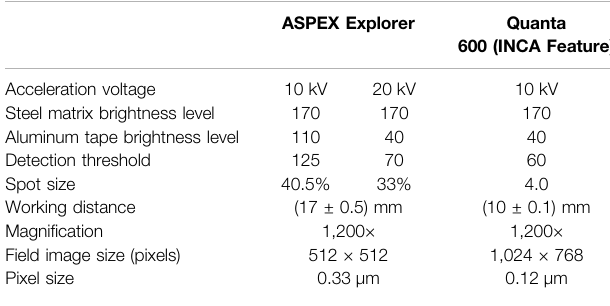
TABLE 1 | SEM settings for automated inclusion analysis